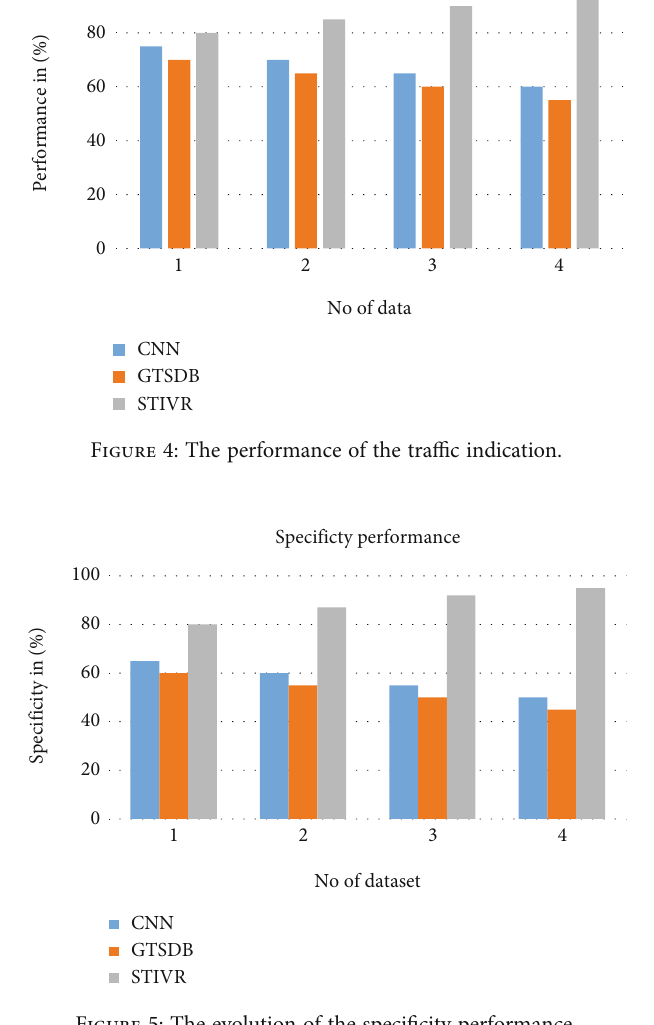
Figure 5: The evolution of the speci fi city performance.